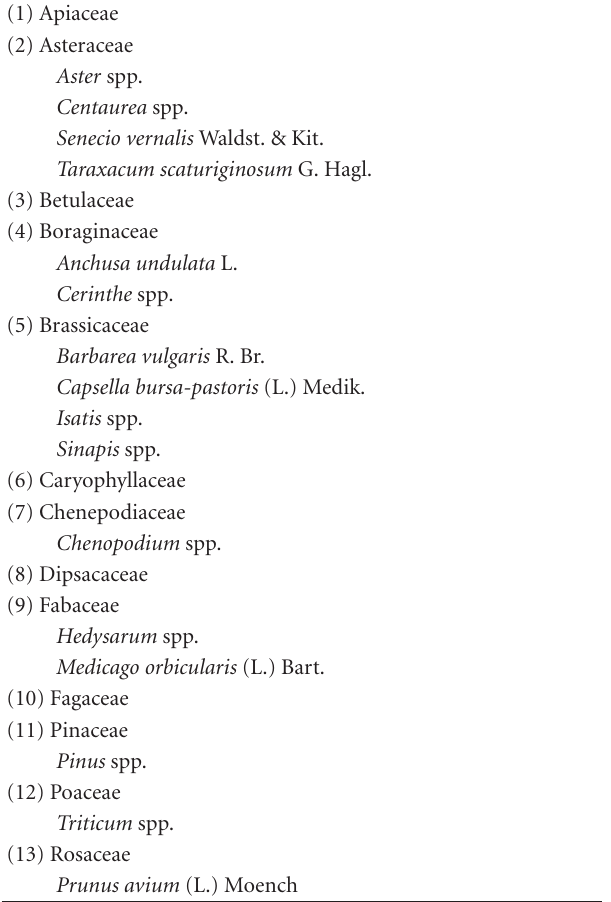
Figure 1: The plants that A. flavipes collected pollen.